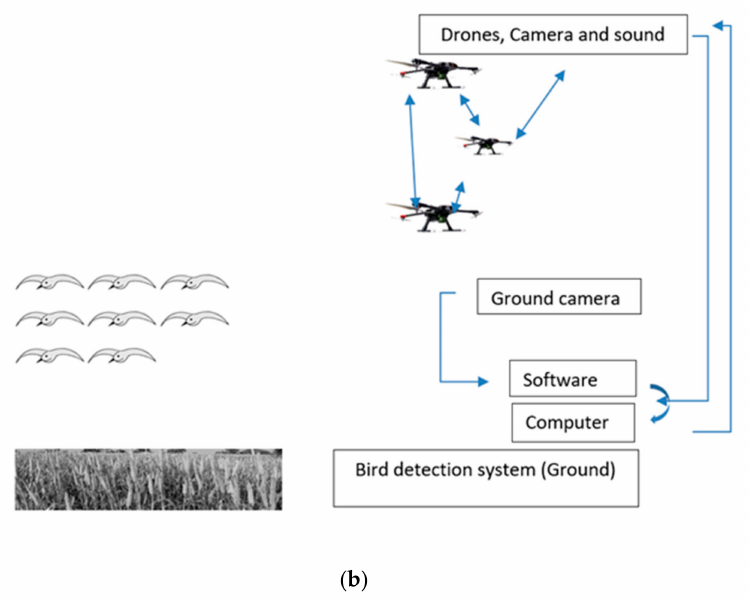
Figure 5. ( a ) Invasion of Quelea birds over a sorghum plantation in Ngenge sub-county, Kween district in eastern Uganda (Xinhua/Daniel Edyegu). Picture taken on 6 July 2013 (photo provided by Rhoda Birech). ( b ) System diagram of the proposed swarm drone bird (Dayoub et. al.,